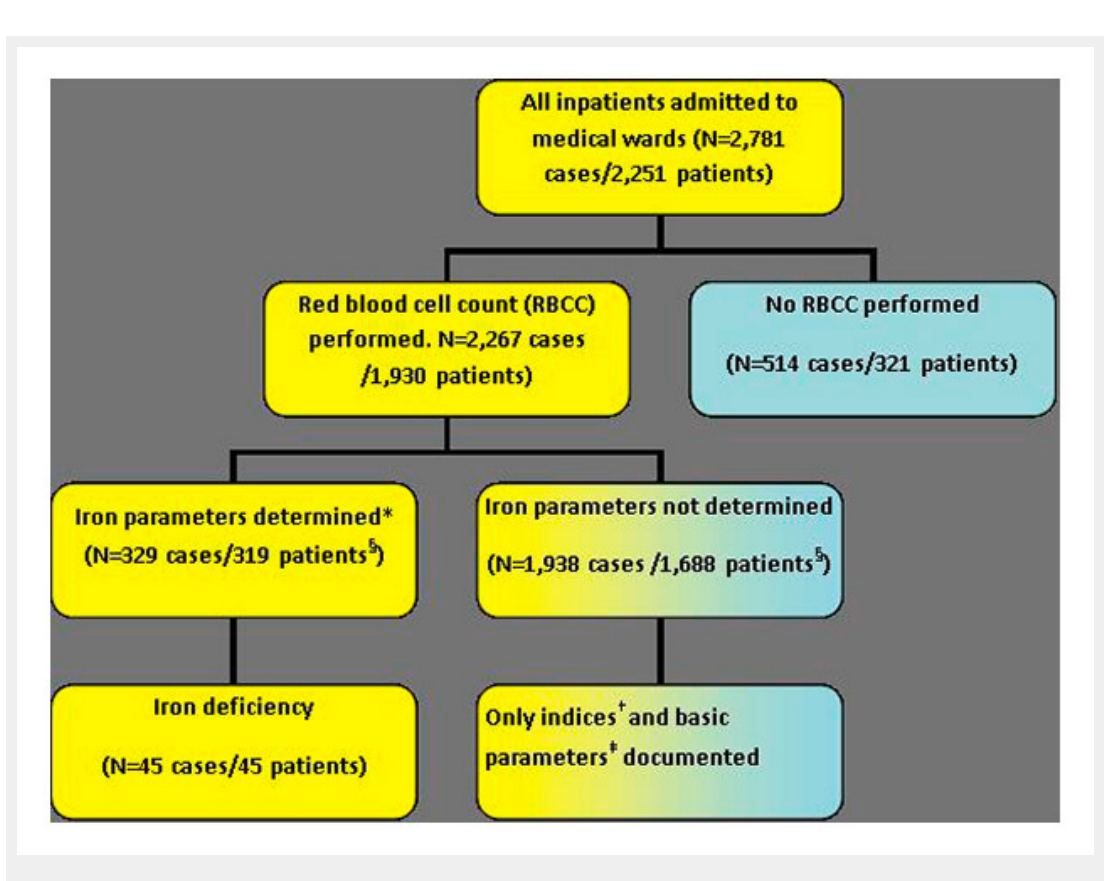
Case inclusion algorithm. * At least ferritin was determined. †Indices = cellular indices such as haemoglobin, mean corpuscular volume (MCV) or the mean cellular haemoglobin concentration (MCHC) ‡ Basic parameters: age, gender, main diagnosis, results of red blood cell count (RBCC) § Number of patients with and without iron parameters do not add up to 1930, because 74 patients had in some cases iron parameters determined and in others